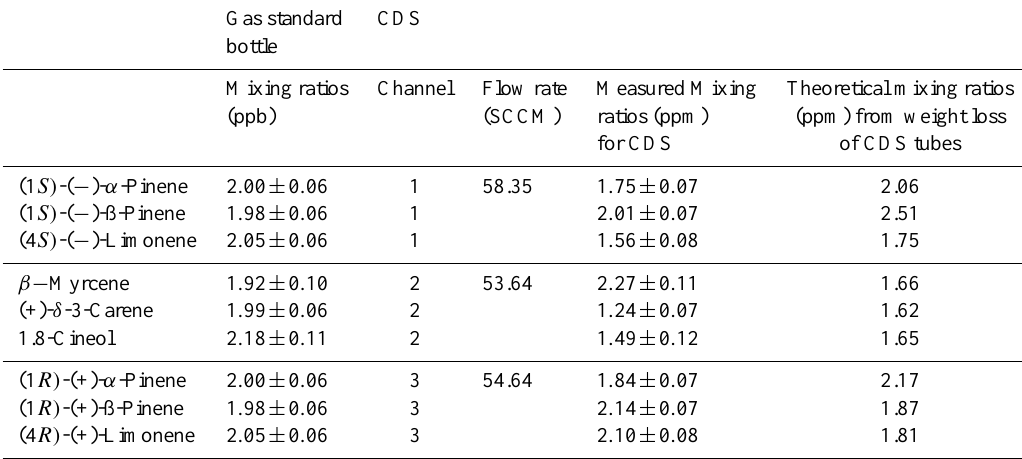
Table 1. Mixing ratios of monoterpenes from the standard gas bottle, measured from CDS and calculated from the weight loss of CDS tubes. Gas standard CDS bottle Mixing ratios Channel Flow rate Measured Mixing Theoretical mixing ratios (ppb) (SCCM) ratios (ppm) (ppm) from weight loss for CDS of CDS